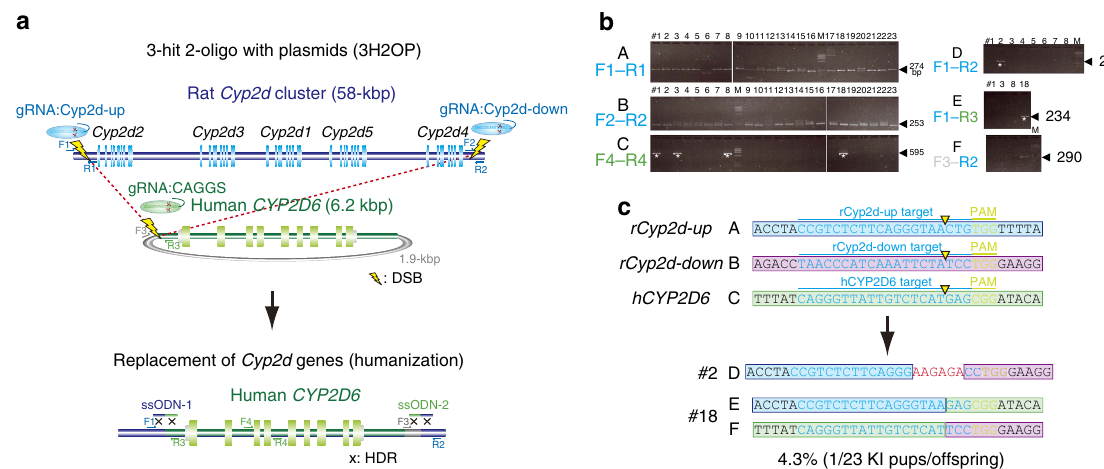
Figure 5 | Replacement of the rat Cyp2d cluster with the human CYP2D6 gene. ( a ) Schematic representation of the 3H2OP method to replace the rat Cyp2d cluster genes, Cyp2d1–5 (58kb), with the orthologous human CYP2D6 gene (6.2kb). Three gRNAs for upstream and downstream of the rat Cyp2d cluster and for the human CYP2D6 plasmid cut the targeting sites, and two ssODNs ligate to each cut end. ( b ) PCR analysis of pups with primer sets F1–4 and R1–4 as indicated in a . Many pups showed indel mutations compared with the wild-type alleles upstream (274bp) and downstream (253bp) of Cyp2d , indicated by arrows (A and B, respectively). Four pups showed a positive PCR band for the human CYP2D6 gene (asterisk) (C). Rat number 18 was positive for ligation between both sides of the rat Cyp2d cluster and human CYP2D6 (D,E). Rat number 2 showed a large deletion from upstream to downstream of the rat Cyp2d cluster (E). Arrows indicate the predicted PCR fragment size. ( c ) Sequence analysis of pups indicated that rat number 18 carried the accurate conjunction at both cut